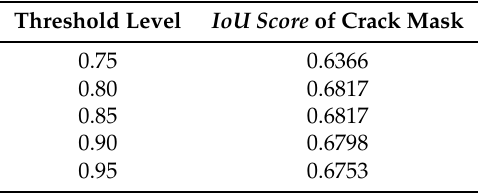
Table 2. Threshold level in Otsu’s method is selected according to IoU score , corresponding to the previously selected batch size and number of